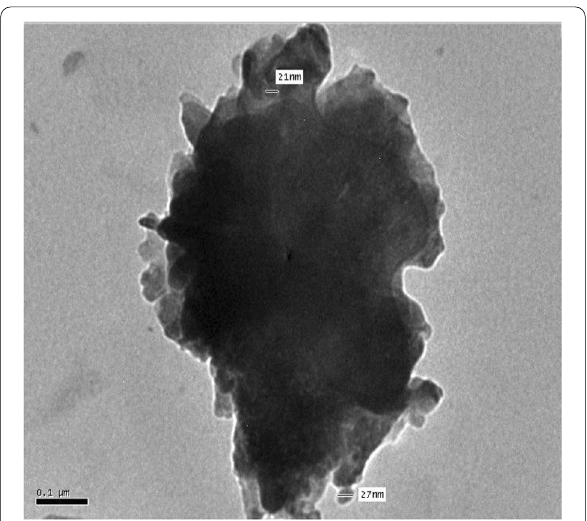
Fig. 2 TEM of pure C 3 A phase